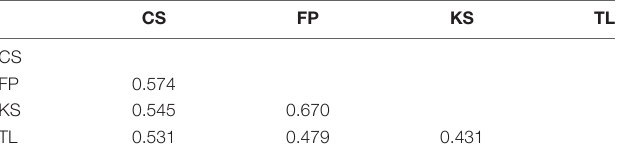
TABLE 3 | Heterotrait-Monotrait Ratio (HTMT). TABLE 4 | Structural